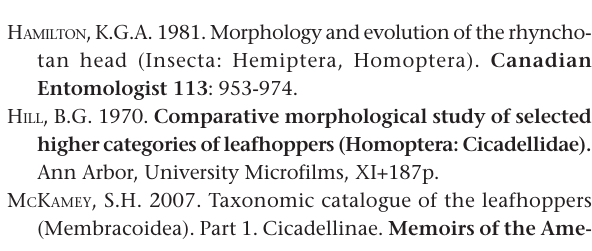
whitish-blue marks: two oblique stripes basally followed by two triangular and two transverse maculae. This pattern is not ob- served in any other species of the genus. Ruppeliana episcopalis and R. glaucomaculata have some bluish marks on the forewings but the pattern is very different from R. caelimaculata . The pat- tern of marks on the forewings of R. flavivirescens and R. nigripes are similar (with about four longitudinal irregular stripes), but the background color and stripes are very different, brownish- red with greenish-yellow stripes in the new species (Fig. 16), and red to dark red with reddish-pink to pale pink stripes in R. nigripes .